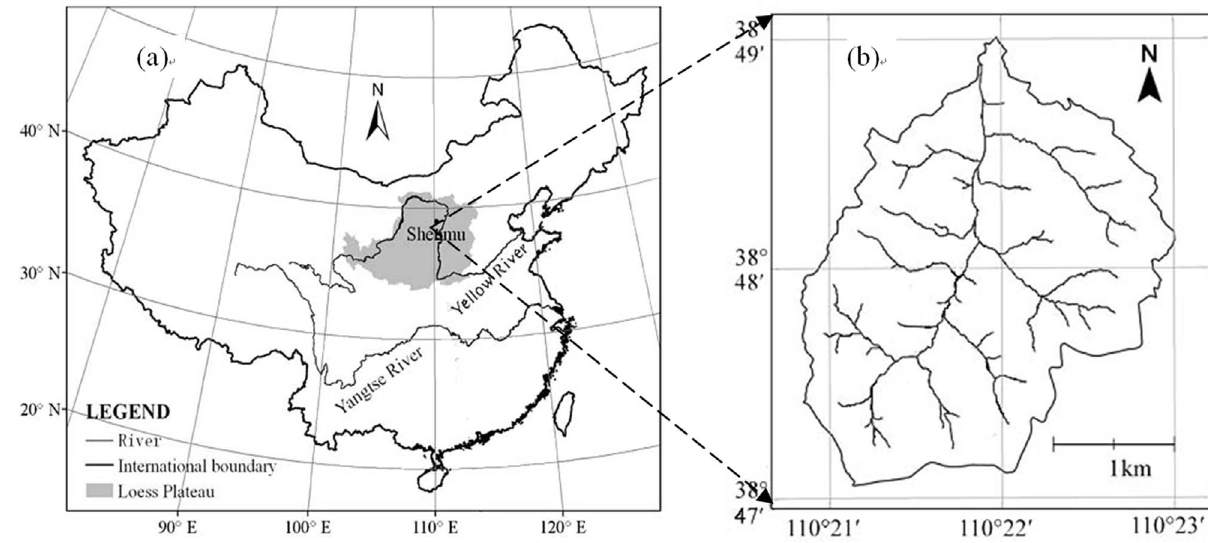
Figure 1. Location of the study site. (a) China; (b) the Liudaogou watershed.